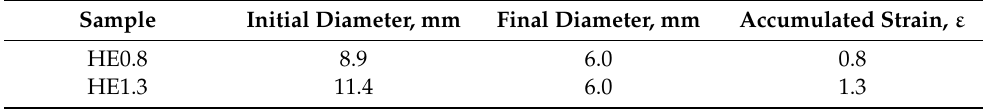
Table 3. Cross-section reduction and accumulated